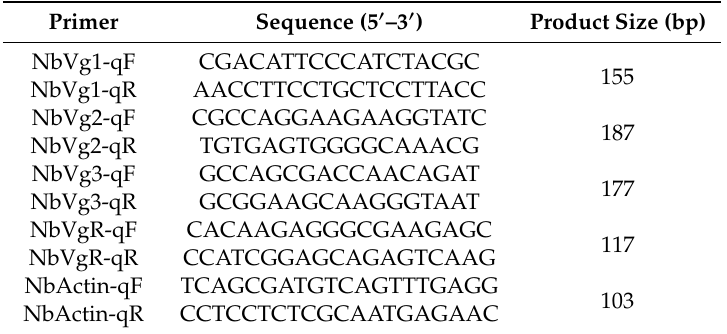
Table 1. Primers used for quantitative real-time reverse transcription polymerase chain